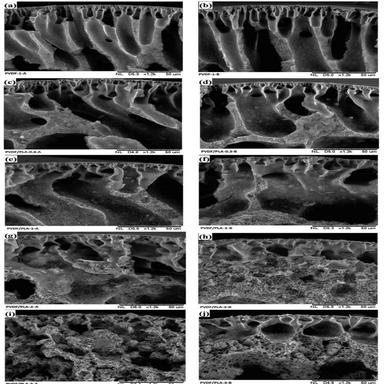
SEM images of cross-sectional structural of hollow fiber membrane with zero (left) and 8-cm (right) air gap for (a,b) PVDF membrane, (c,d) PVDF/PLA-0.3 membrane, (e,f) PVDF/PLA-1 membrane, (g,h) PVDF/PLA-2 membrane, and (i,j) PVDF/PLA-3 membrane.